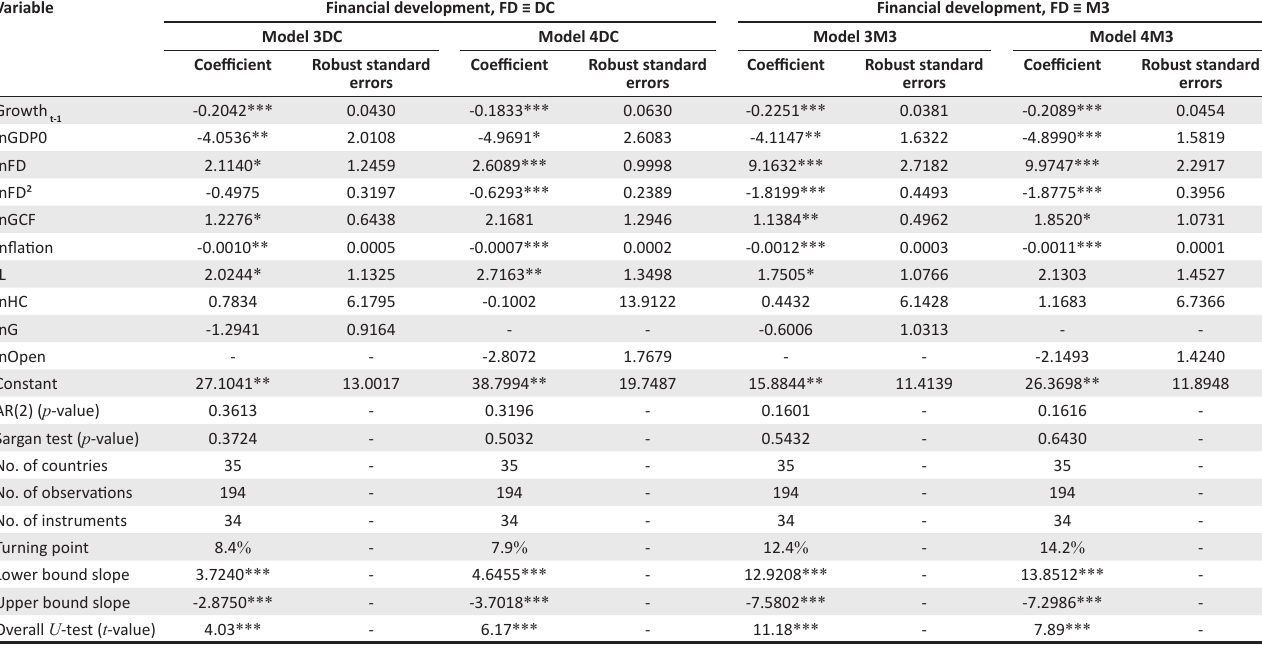
TABLE 4: Two-step system-generalised method of moments estimations with an additional explanatory variable. Variable